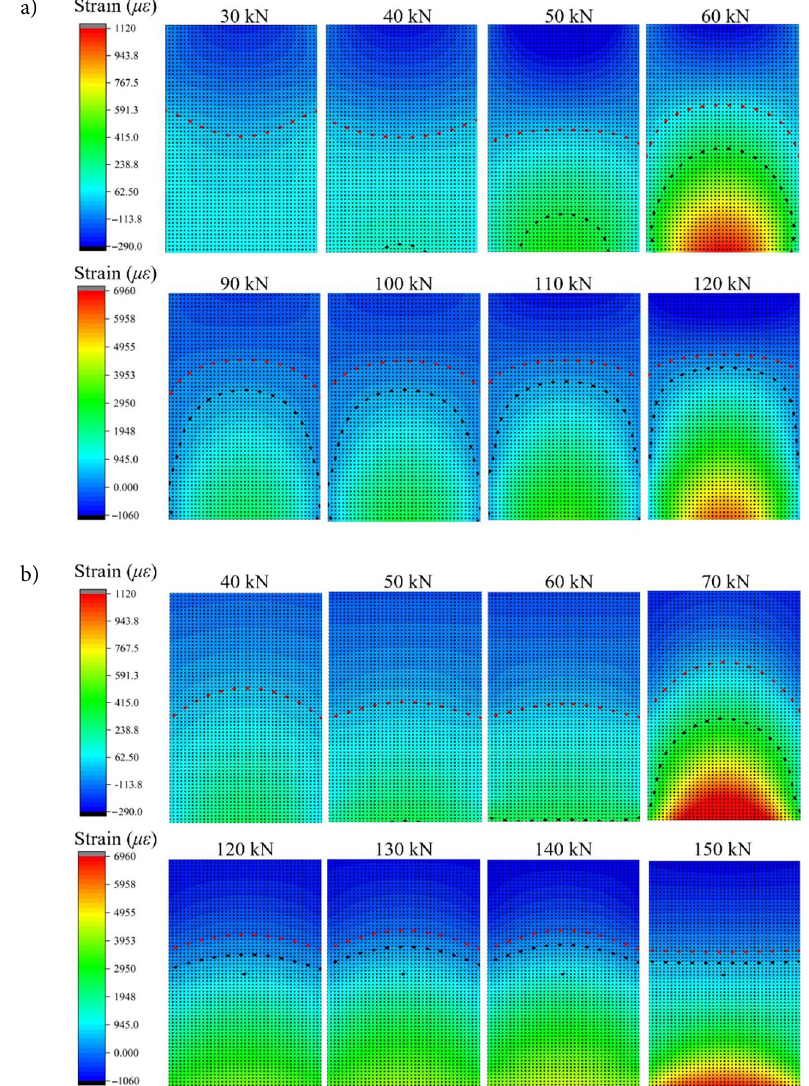
Figure 12. The strain contour maps: a – Beam numbered BB0; b – Beam